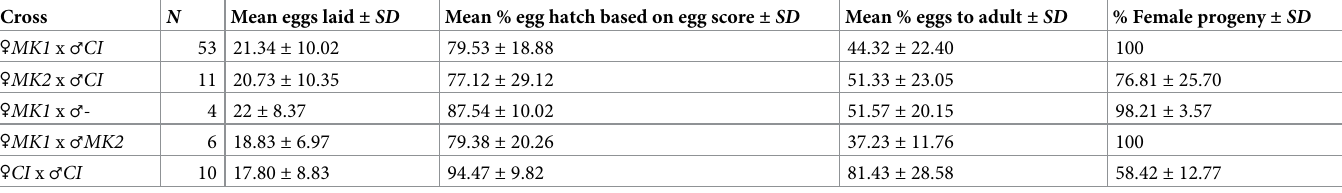
MK1 females are from parents producing female-only offspring and MK2 females are from parents producing both male and female offspring. N is the number of replicates after those that did not mate and those that had < 7 eggs were